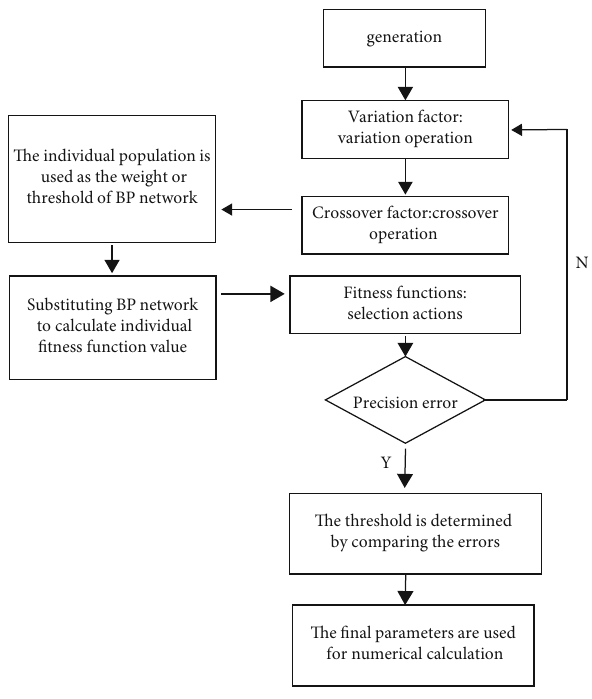
Figure 3: Algorithm fl